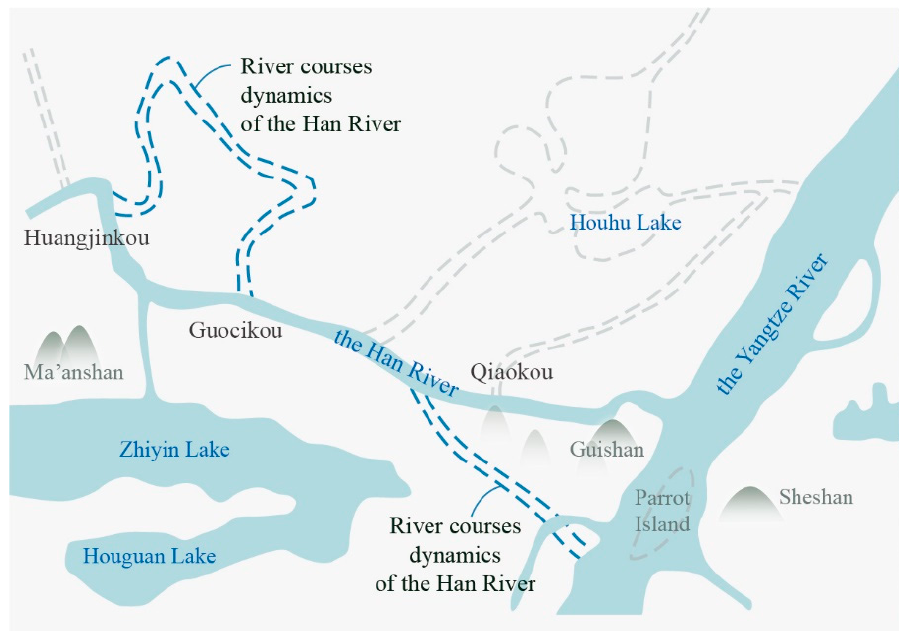
Figure 9. Map of the river course dynamics around the Han River.